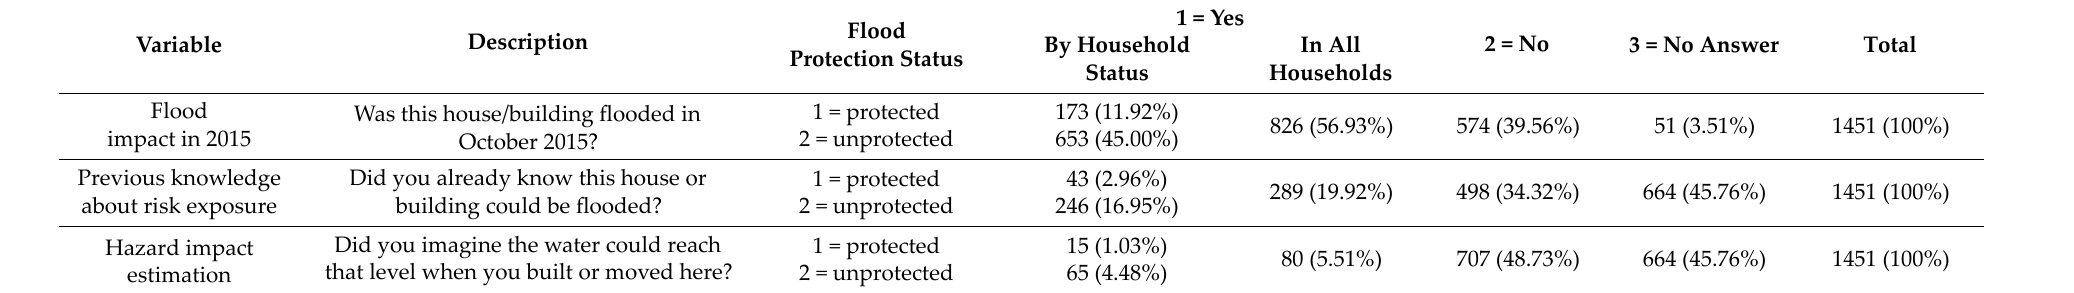
Table 2. Flood risk perception among households.